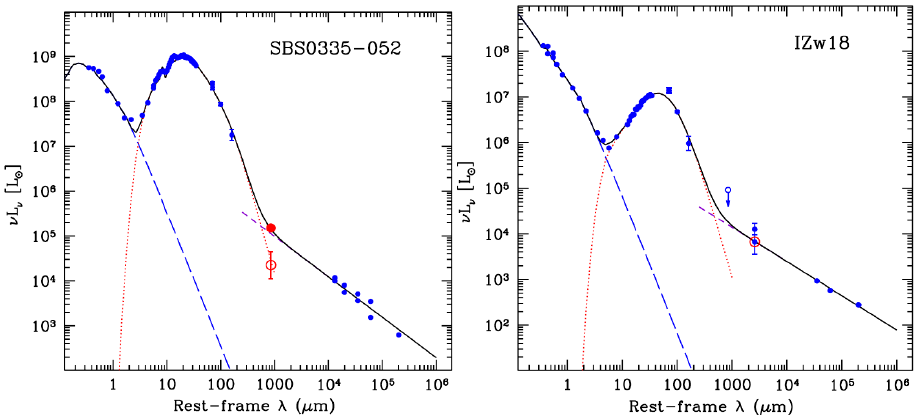
Figure 8. Spectral Energy Distributions (SEDs) from SBS 0335–052 ( left ) and IZw18 ( right ). The black lines respresent fits using DUSTY models, the blue dashed lines show the stellar contributions, the dotted red lines give the contributions from the dust and the dashed purple straight line (mostly undistinguishable from the total emission) provides the radio continuum at long wavelengths. Left : The filled red circle indicates the total λ = 850 µ m continuum emission from 0. (cid:48)(cid:48) 7 × 0. (cid:48)(cid:48) 45 ALMA data, while the empty red circle stands for the dust contribution. Right : The empty red circle surrounds the dust contribution suggested by [171], while the blue filled circle above includes the entire λ = 2.6mm emission. From